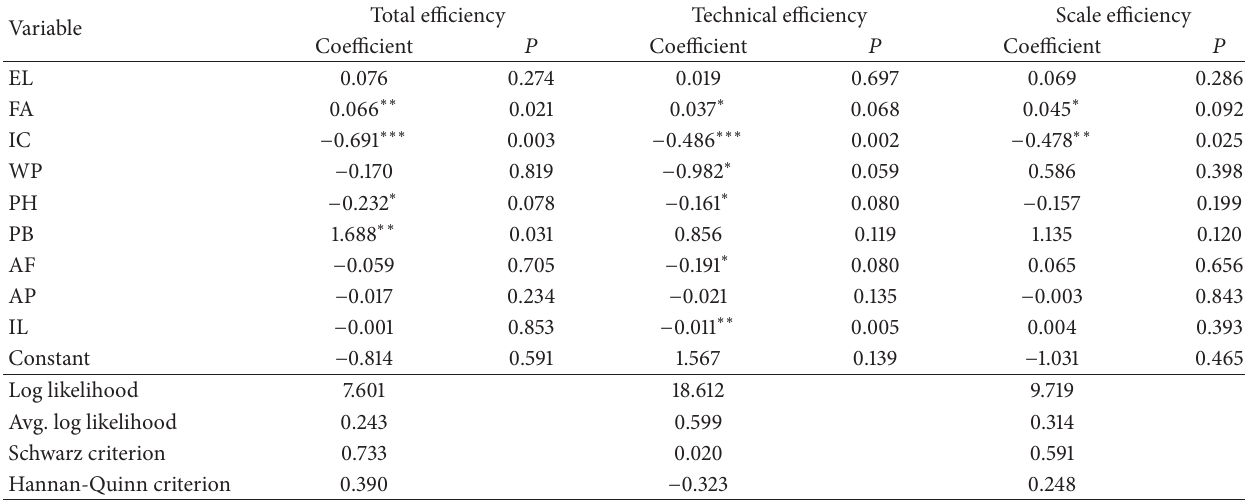
Table 8: Tobit regression results of influencing factor